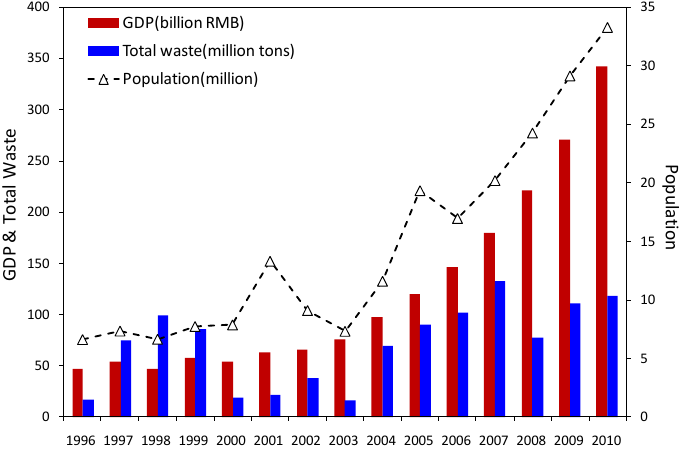
Figure 7. Social and economic indices including GDP, population, and total waste in Lake Chaohu Basin, 1996 to